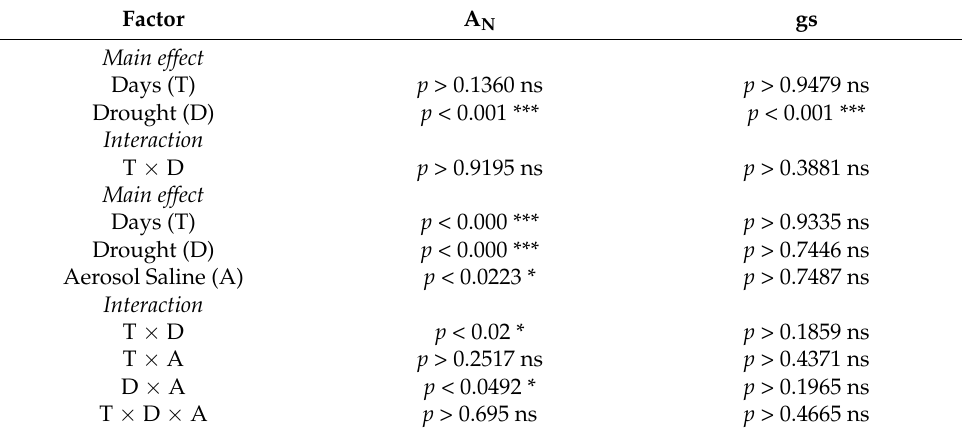
and stomatal conductance (gs) of potted Callistemon .